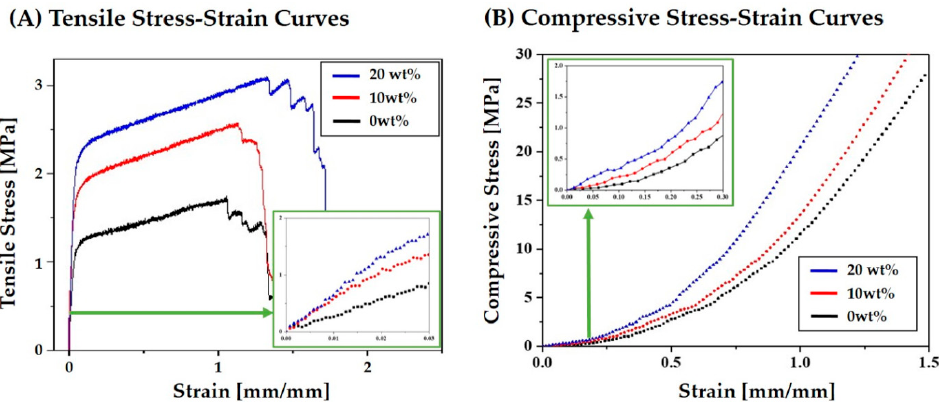
Figure 13. Representative stress versus strain responses of the hierarchical porous PCL–CaP composite scaffolds produced using various CaP contents (0, 10, and 20 wt%) during ( A ) tensile and ( B ) compressive strength tests.